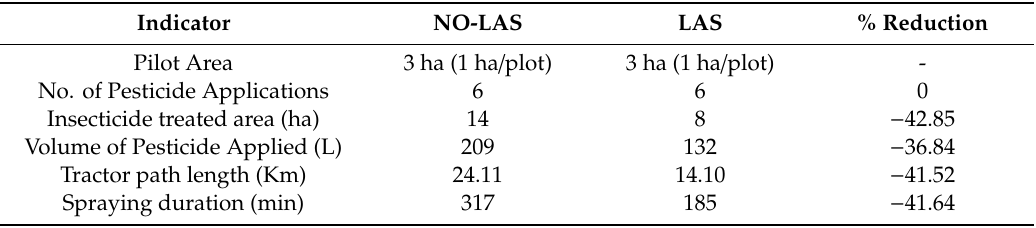
Table 2. Indicators of the efficacy of DSS for controlling B. oleae in the LAS plots compared to conventional control in the NO-LAS plots during the pilot trial: Number of pesticide applications, insecticide treated area, volume of pesticide applied, tractor path length, and duration of insecticide treatments.